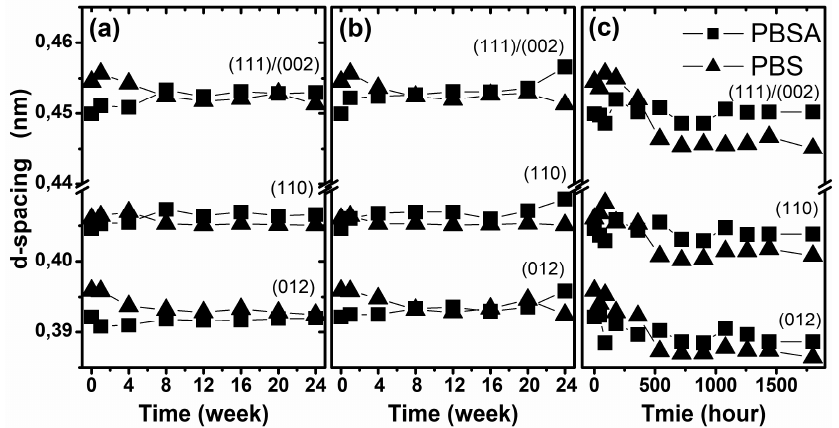
Figure 7. Changes in the d-spacing of the studied samples during degradation in selected environments: ( a ) biodegradation in compost, ( b ) biodegradation in soil and ( c ) artificial weathering.